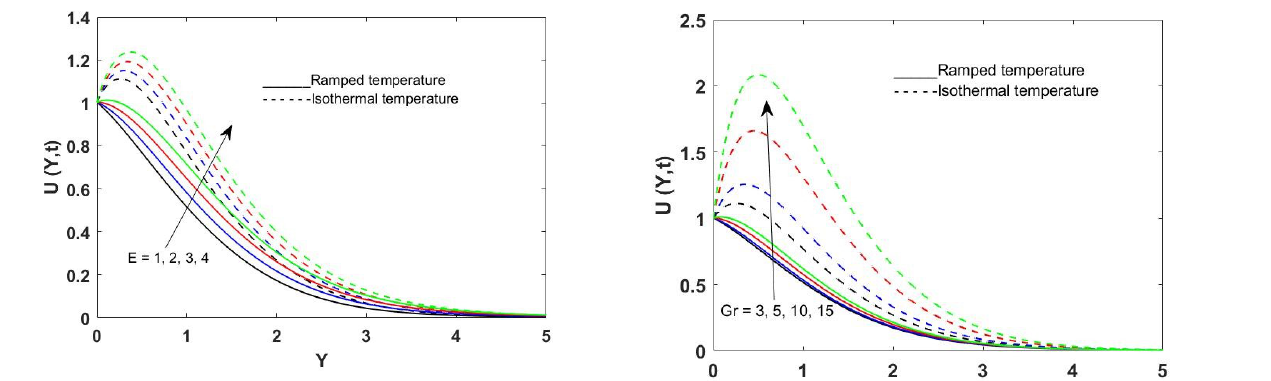
Figure 4: Momentum distribution versus E t =0.3, R=0.2, S=1, K=1, kp=1.5, Q=0.2, Ω = 30 0 , ψ = 0.5 , Pr =0.71, Sc =0.60, Gr=3, Gc=4